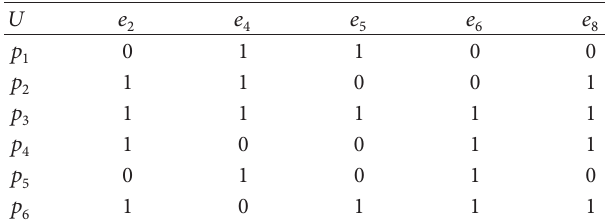
Table 2: Tabular representation of the soft set T 2 = 𝐿( S ;0.6) .